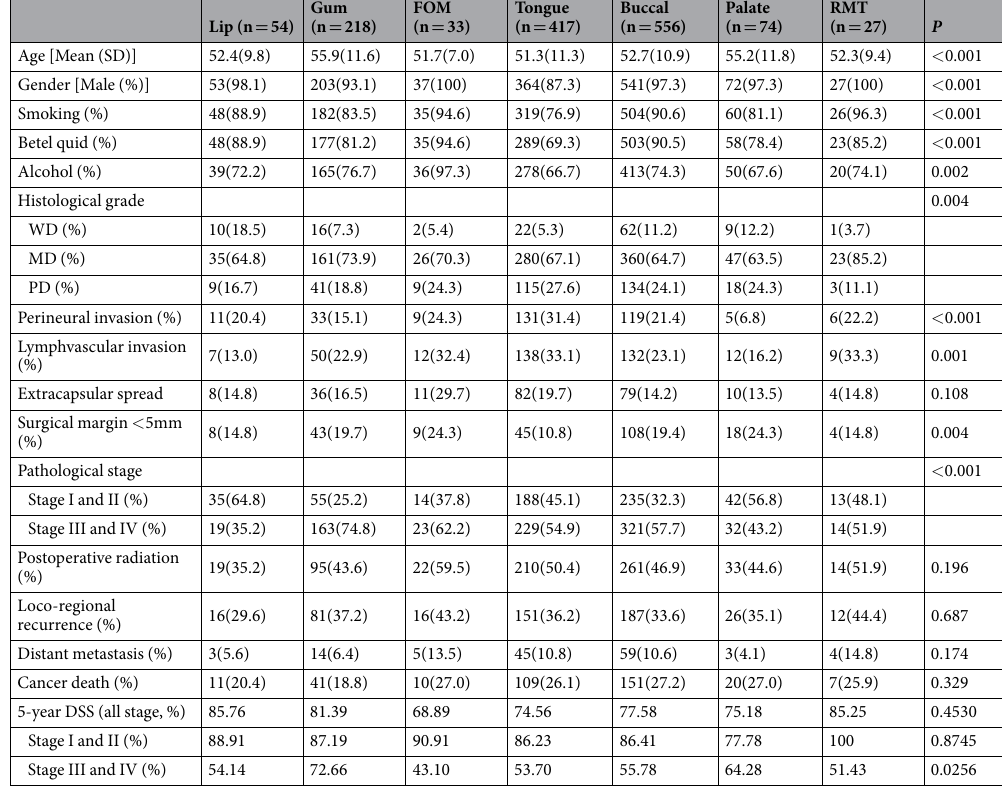
Table 1. Comparison of variables among subsites of oral squamous cell carcinoma patients. SD: standard deviation; WD: well differentiated; MD: moderately differentiated; PD: poorly differentiated; FOM: floor of mouth; RMT: retromolar trigone; DSS: disease-specific